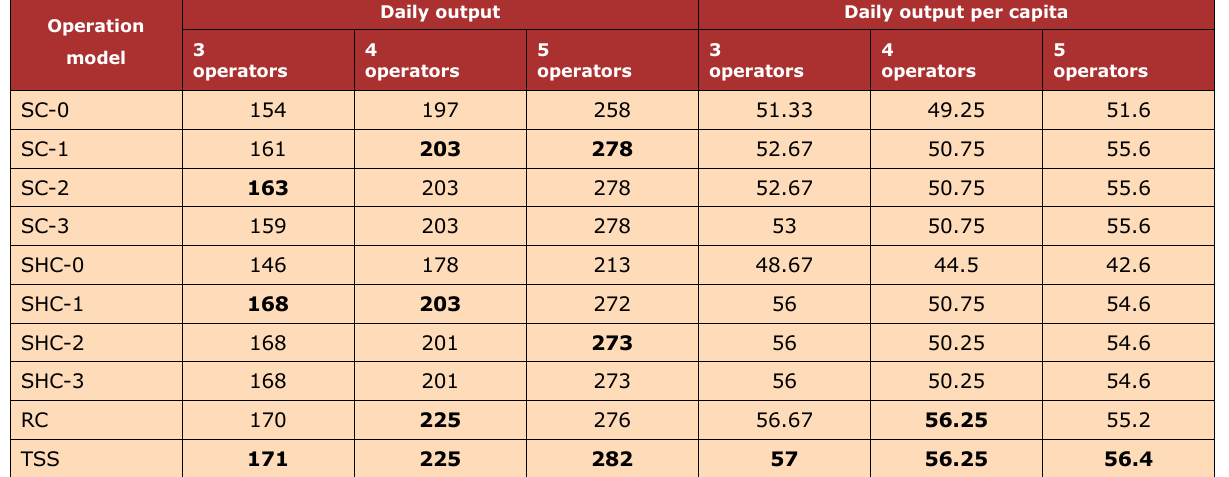
Table 3. Test result of output